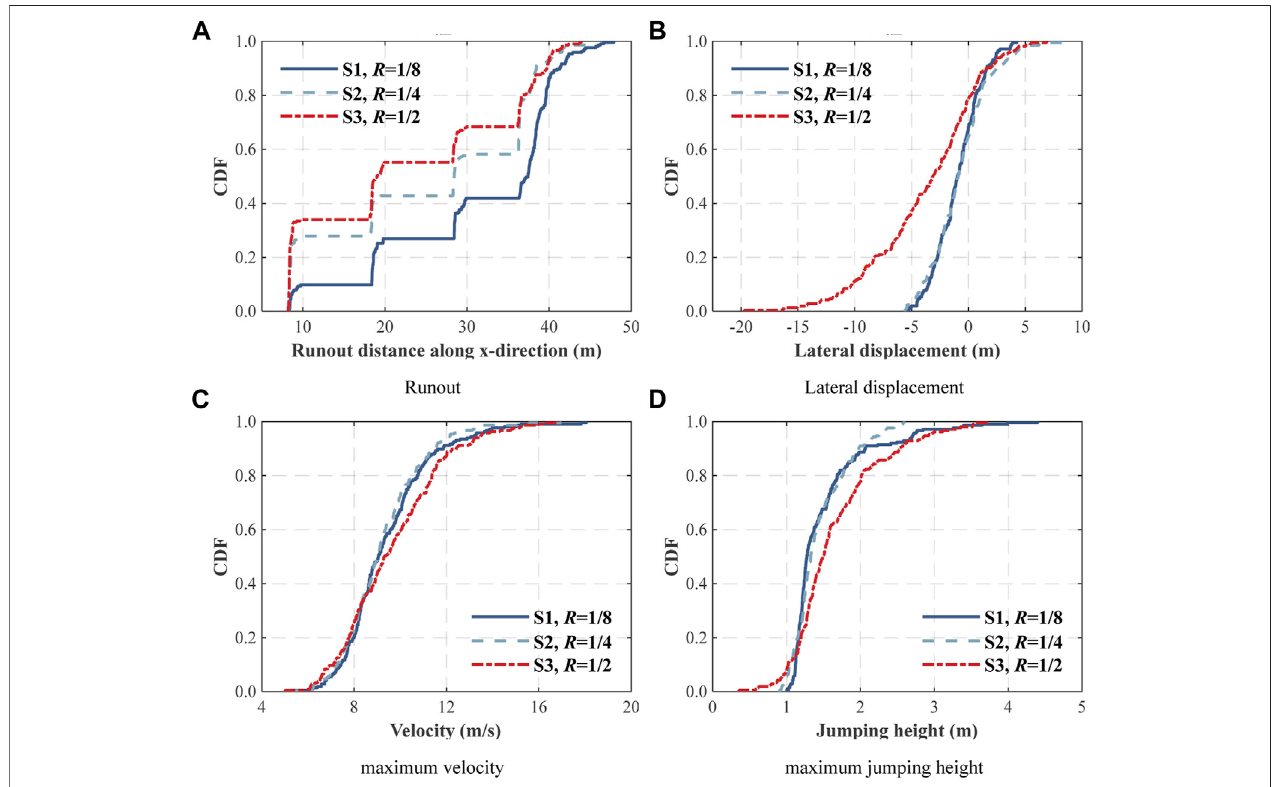
FIGURE 12 | Model results for a case with different rock block sphericities: (A) runout distance; (B) lateral displacement; (C) maximum velocity; and (D) maximum jumping height.